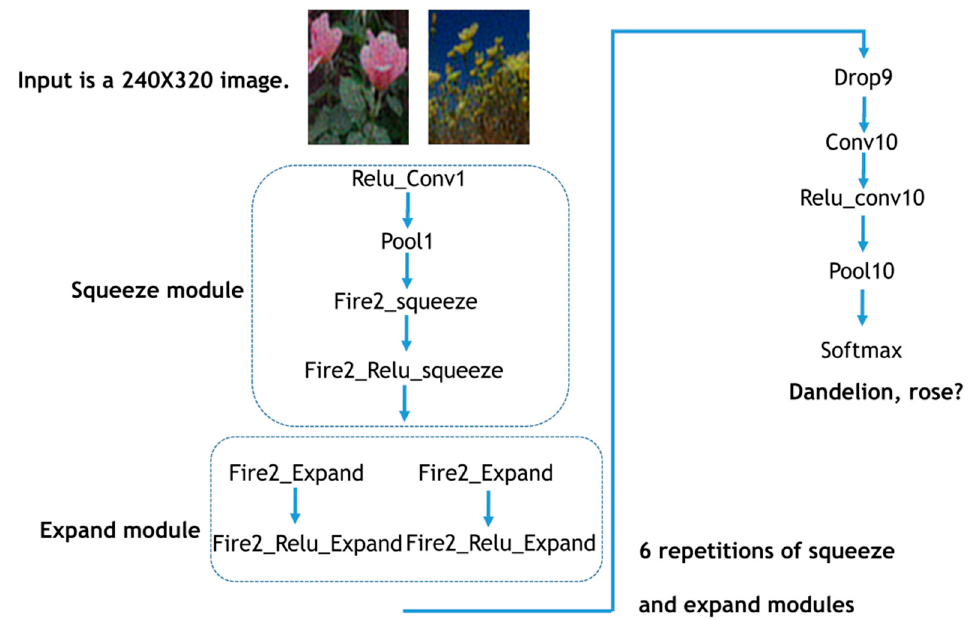
Figure 6. SqueezeNet convolution neural network architecture for image classification training using the flowers dataset. Fire2_squeeze means the second stage squeeze module.